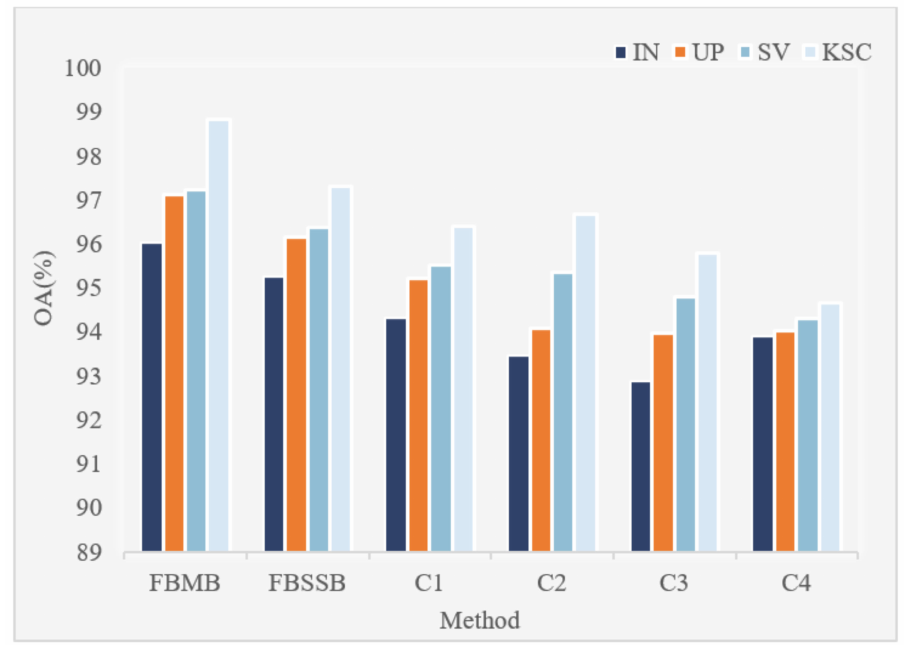
Figure 13. Comparative experiments results of FBMB, FBSSB, C1, C2, C3 and C4 on different data